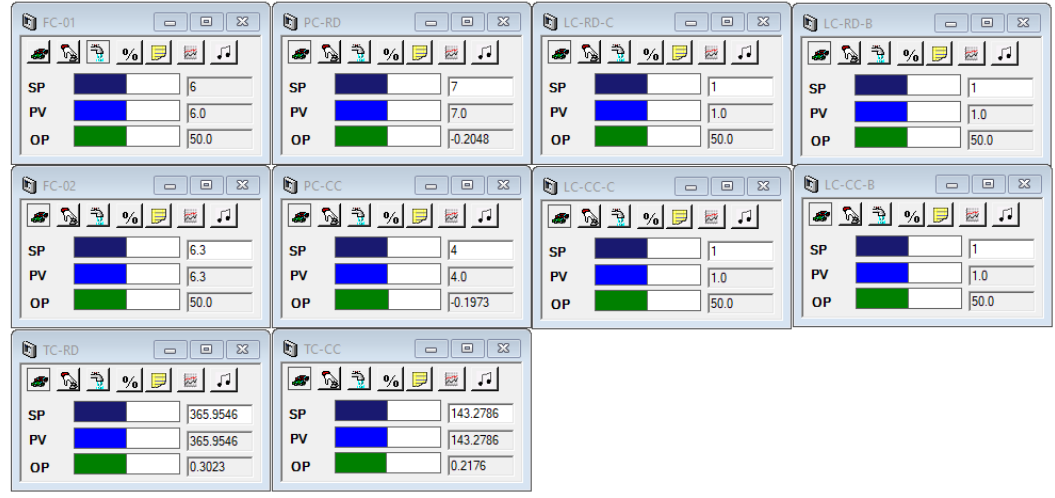
Figure 8. Control scheme faceplates of the process.